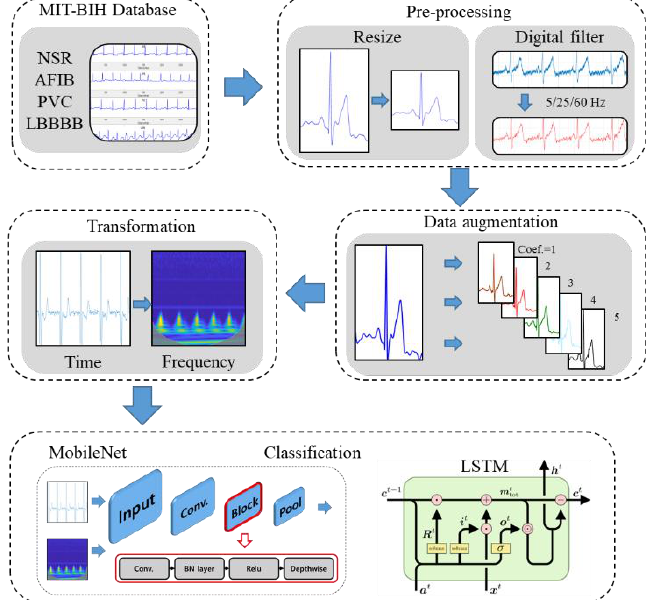
Figure 2. Workflow of the proposed algorithm. This algorithm randomly replicates ECG signals and classifies them into four classes using MobileNetV2 and BiLSTM. The data were duplicated using a matching pursuit algorithm. Time domain data were converted to frequency domain using wavelet transforms.